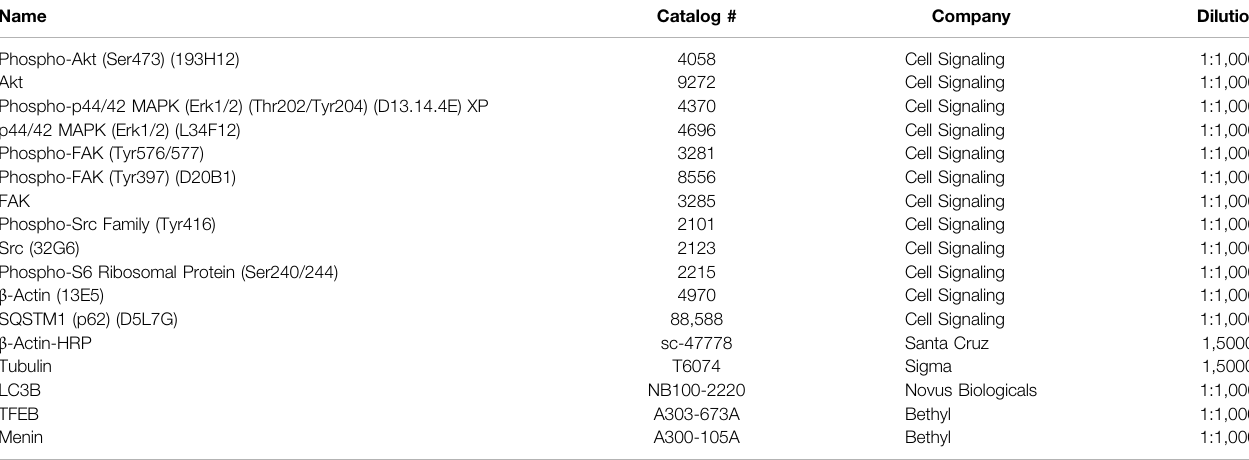
TABLE 2 | List of the primary antibodies used for western blot